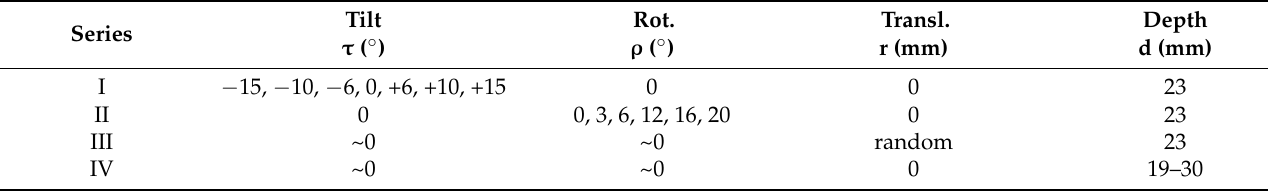
Table 3. In vitro